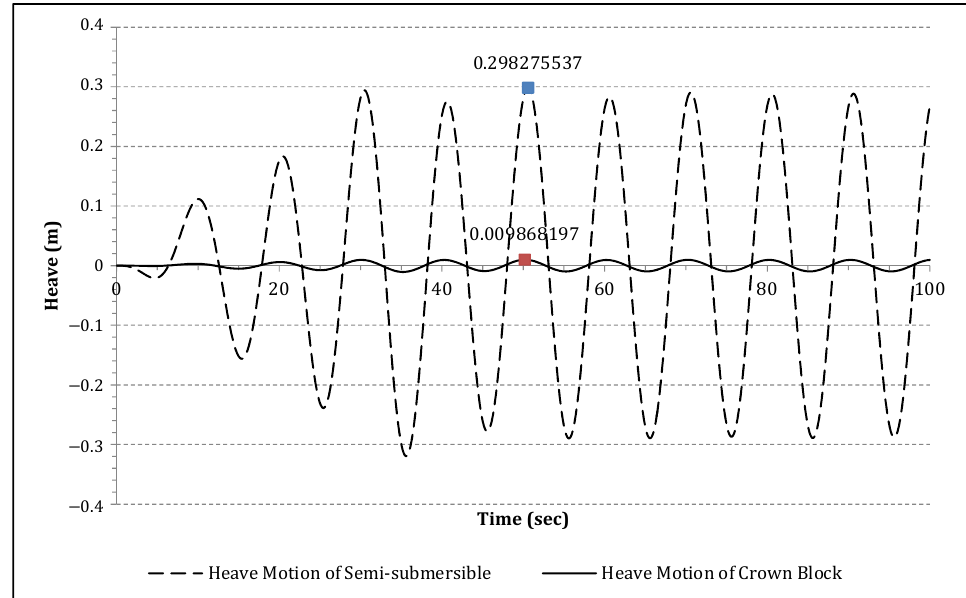
Figure 14. Dynamic response analyses of the semi-submersible and crown block with the heave compensation system for a 2-m wave amplitude.